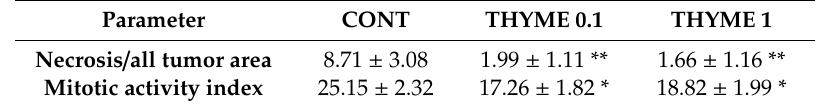
Figure 1. Tumor volume of 4T1 mammary gland cancer in mouse model during the experiment. Data are expressed as mean ± SEM. Significant differences: * p < 0.05, ** p < 0.01, *** p < 0.001 versus CONT. Table 2. Histopathological characteristics of 4T1 tumors in Balb/c mice after T. vulgaris treatment.